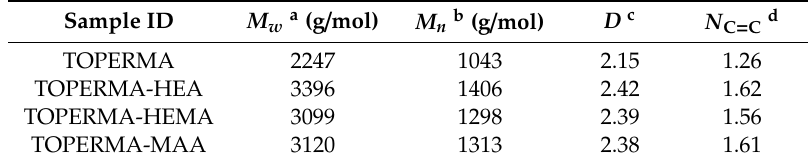
Figure 1. Gel permeation chromatography (GPC) chromatographs of TO-based maleate and Co-UEs. Table 1. Data of Characterization of TOPERMA and TO-based Co-UE